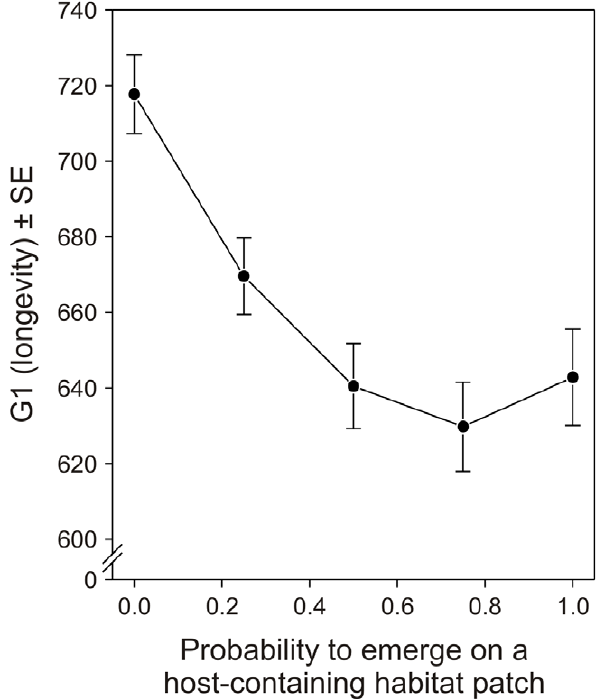
Figure 2. Effect of habitat patch quality and inter-patch travel time on the optimized values of the parameter G1. Average ( 6 SE) optimized values for the parameter G1 defining the initial reproductive strategy on the trade-off between longevity and egg load (see Figure 1) for parasitoid females foraging for hosts in environments with different habitat patch qualities and different inter-patch travel times.